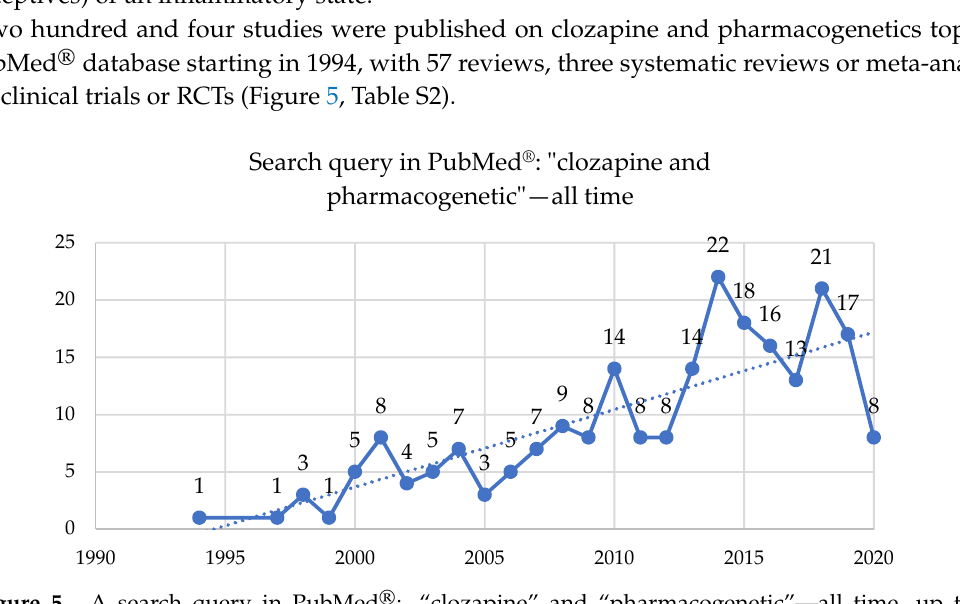
Figure 5. A search query in PubMed ® : “clozapine” and “pharmacogenetic”—all time, up to 15/8/2020.